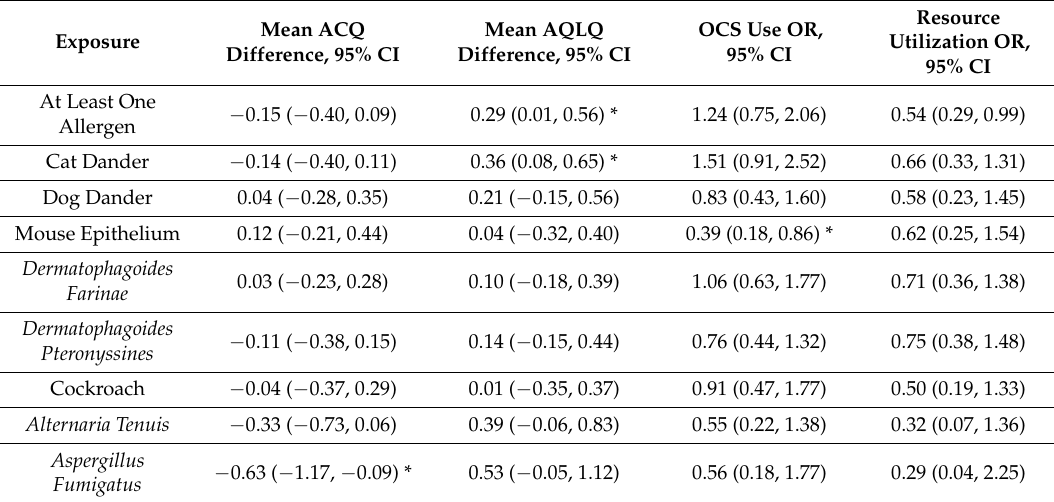
Table 3. Unadjusted associations between sensitization to indoor allergens and asthma morbidity in World Trade Center rescue and recovery workers.